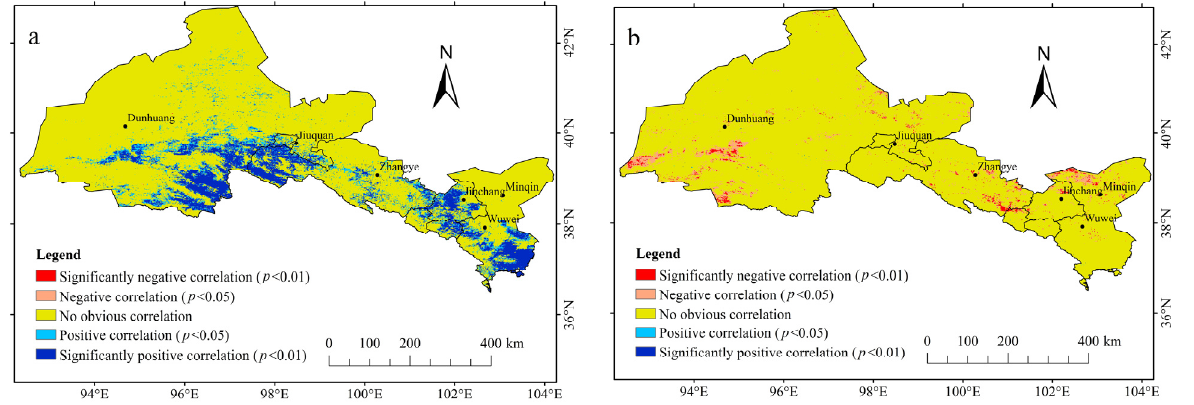
Figure 5. Correlation analysis of NDVI and ( a ) precipitation and ( b ) temperature changes in the Hexi Corridor during 2000–2020.